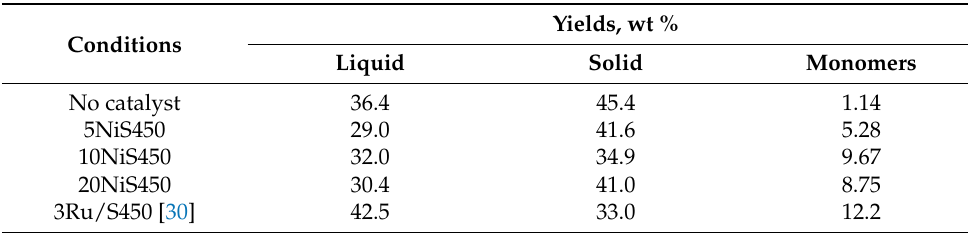
Table 3. Effect of the metal content in a catalyst on the fractionation product yield of flax shives (225 Table 4. Effect of the metal content in the catalyst on the composition of solid products from the ° С , 3 h). fractionation of flax shives (225 ◦ C, 3 h).